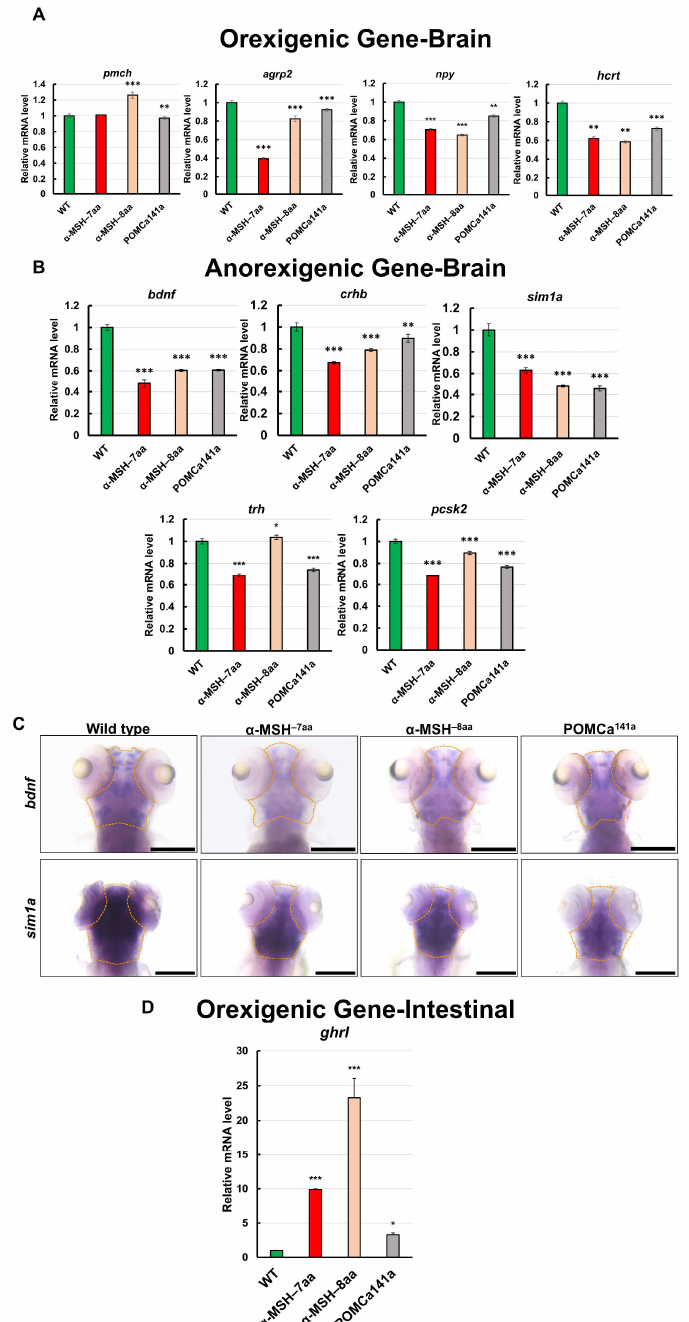
Figure 5. Effects of α-MSH on feeding regulation in the hypothalamus of zebrafish. ( A , B ) RT–qPCR analysis was used to measure the mRNA levels of four selected orexigenic genes, pmch , agrp2 , npy , and hcrt ( A ), and five selected anorexigenic genes, bdnf , sim1a , crhb , trh , and pcsk2 ( B ) in the WT and pomca mutants at 1.5 h after feeding. ( C ) Whole-mount ISH showing decreased expression of bdnf and sim1a in the pituitary in WT and pomca mutant larvae at 5 dpf. Scale bars, 200 μm. ( D ) RT–qPCR analysis was used to measure the mRNA level of the intestinal orexigenic gene, ghrl , in WT and pomca mutant adults. Values are means ± SEM. * p < 0.05, ** p < 0.01, and *** p < 0.001 compared with WT control